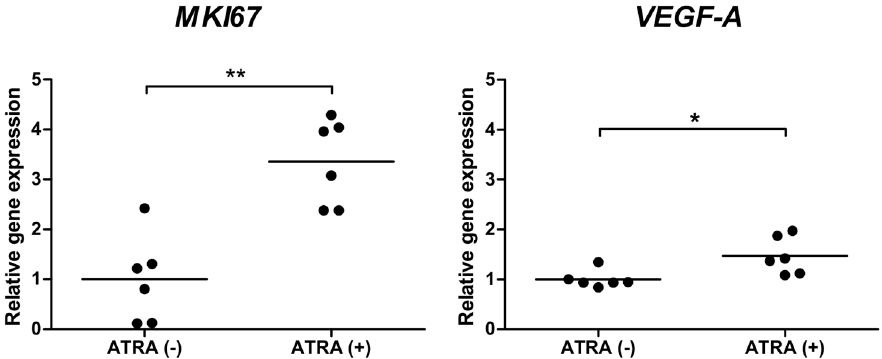
Figure 6. Gene expression of VEGF-A and MKI67 in ATRA-treated and control ARPE-19. The analysis was conducted using Quantitative Real Time-PCR. GAPDH was used as a reference gene and the expression of target genes in the control group was assigned a value of 1.0. Displayed is the mean ± SEM, n = 6, * p < 0.05, ** p < 1